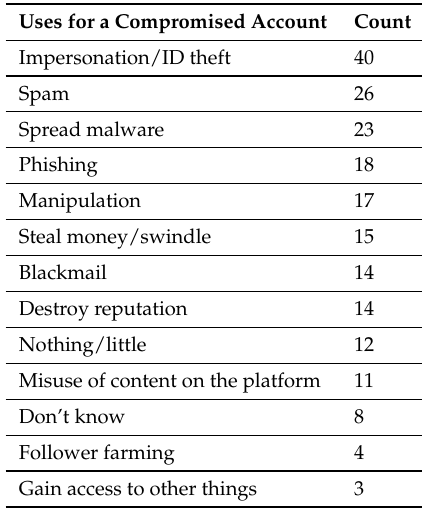
Table 26. Grouped open answers that a compromised account can be used for. N =